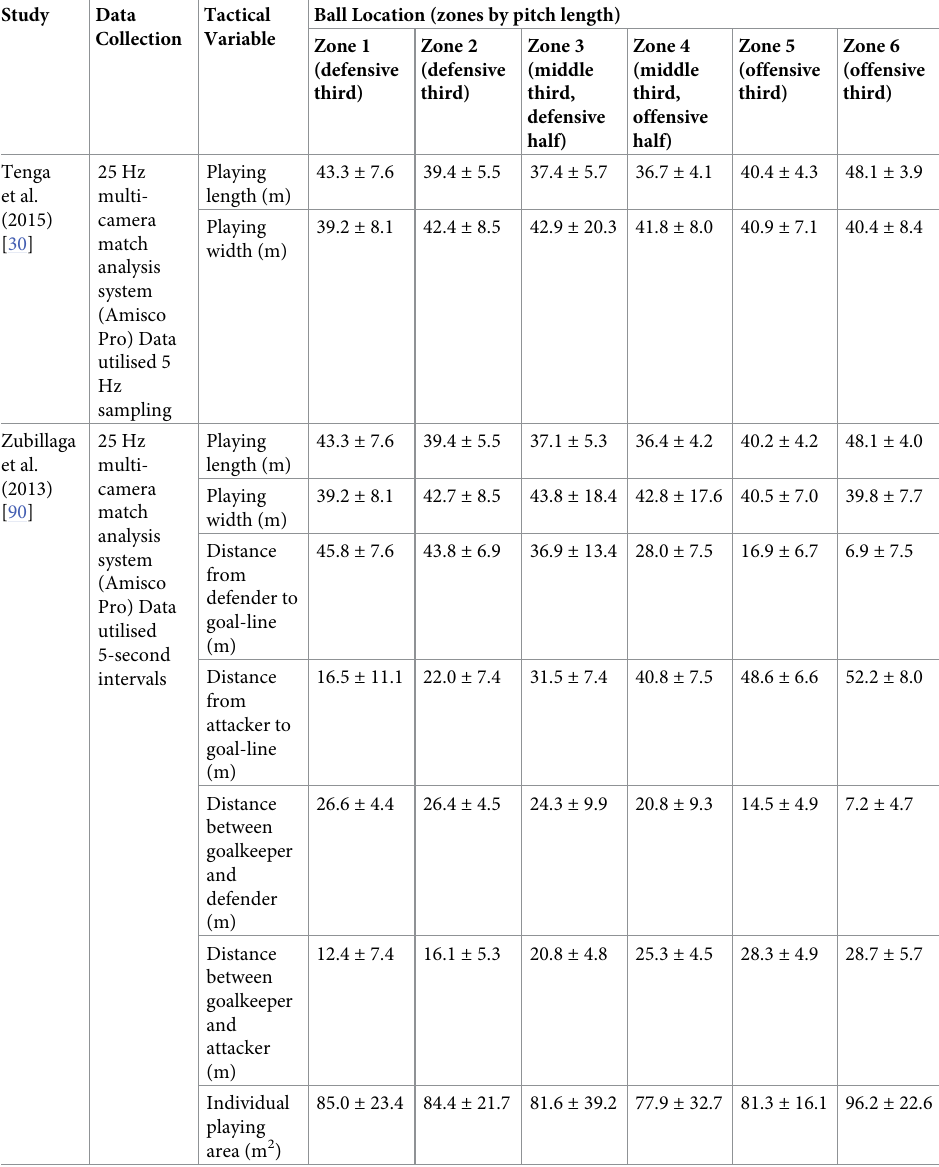
Table 10. Studies quantifying tactical characteristics of women’s soccer